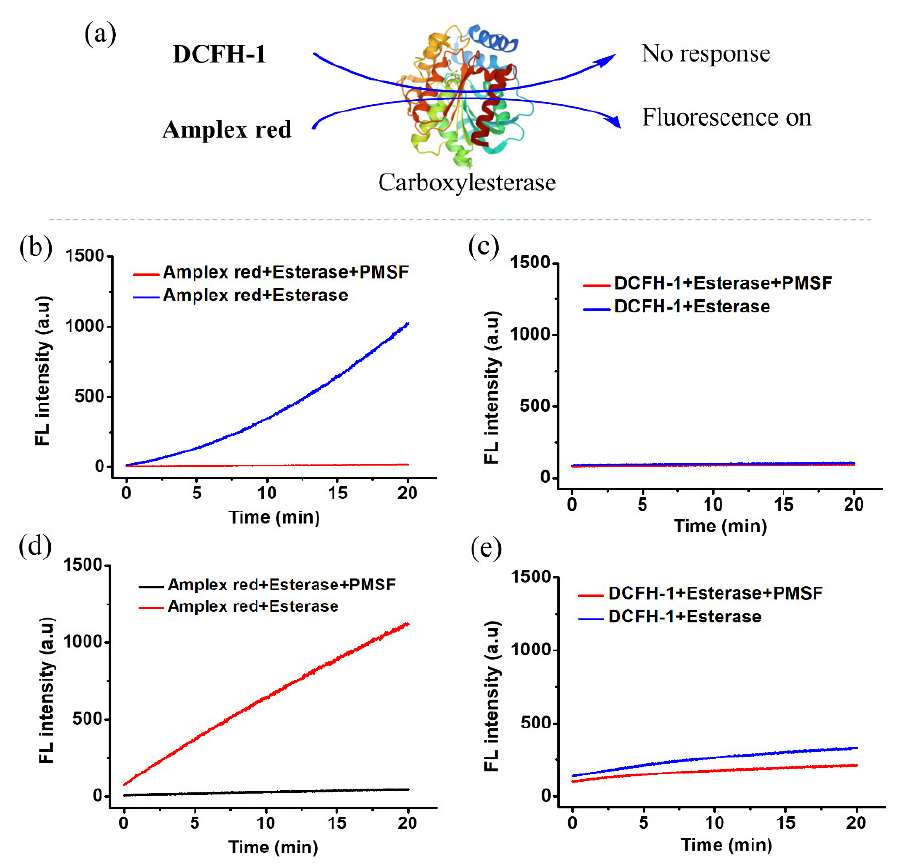
Figure 5. ( a ) Schematic figure shows nonspecific responsiveness of Amplex red and DCFH-1 toward carboxylesterase; ( b , c ) the kinetic fluorescence responses of Amplex red and DCFH-1 upon incubation with the commercialized pure enzyme; and ( d , e ) the kinetic fluorescence responses of Amplex red and DCFH-1 upon incubation with the protein extracts from the mouse liver tissues. PMSF was applied as an inhibitor to carboxylesterase.